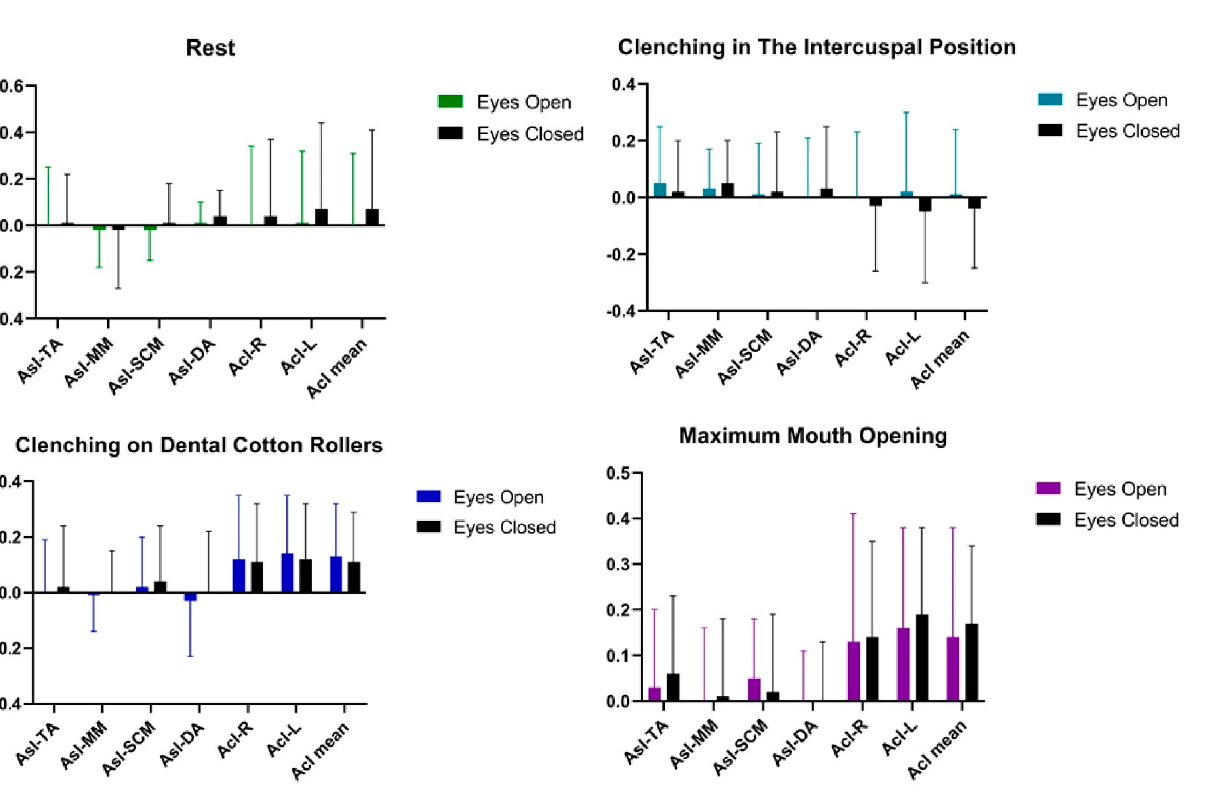
Figure 3. Graphical representation of bioelectrical patterns of selected muscles of the masticatory and cervical spine muscles in women. AcI—Activity index; AsI—Asymmetry Index; TA—the anterior part of the temporalis muscle; MM—the superficial part of the masseter muscle; SCM—the middle part of the sternocleidomastoid muscle; DA—the anterior belly of the digastric muscle. Statistical analysis of bioelectrical activity performed on the male group showed no significant statistical differences in the tested muscle activities of TA, MM, SCM, DA between the tests (Table 4 and Figure 4). Table 4. Results of comparison of bioelectrical activity of selected muscles of the masticatory and cervical spine muscles in men.